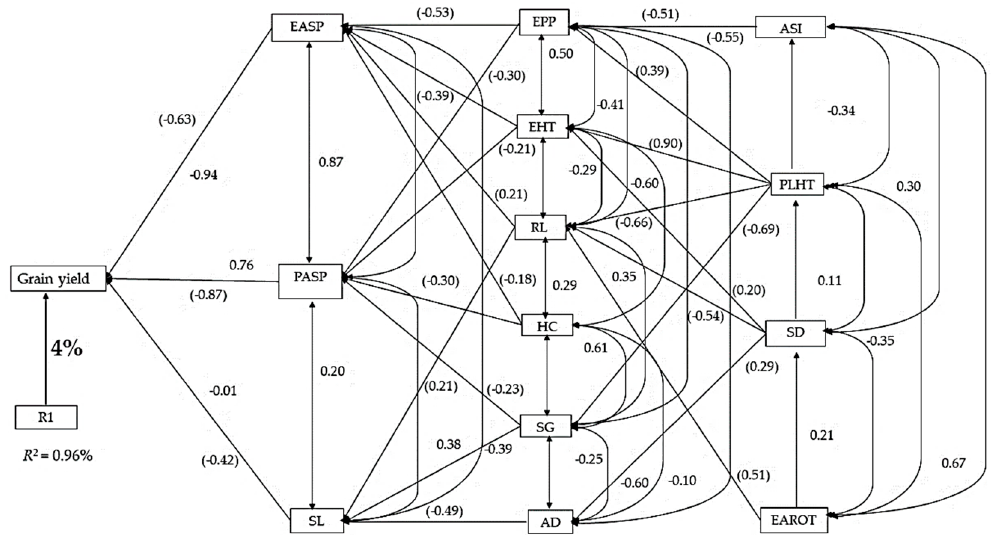
Figure 3. Path analysis diagram depicting the causal relationship of measured traits of the 72 maize accessions under drought-stressed conditions. Note: Value written in bold is the error effect; the direct path coefficients are values in parenthesis and other values are correlation coefficients. R1 is error effects, R 2 = coefficient of determination. AD: Days to 50% anthesis; SD: Days to 50% silking; ASI: